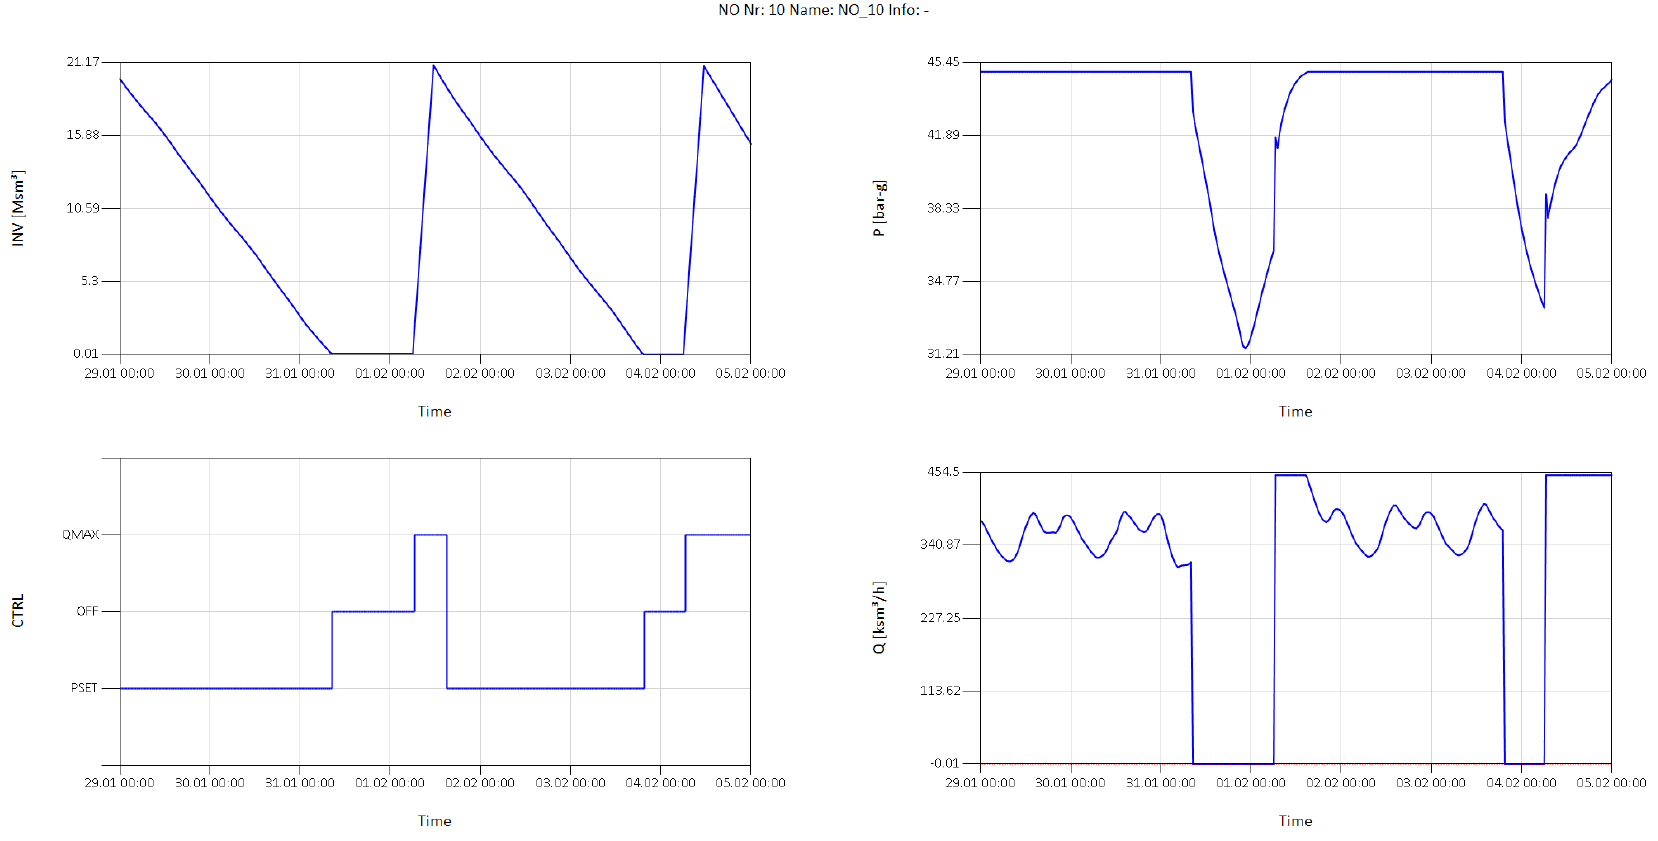
Figure 12. Time evolution of working gas inventory (NO.10.INV), station control (NO.10.CTRL), pressure (NO.10.P) and gas supply (NO.10.Q) at liquefied natural gas (LNG) Terminal NO.10 for DA simulation for Q1 and for a 20% wind and solar